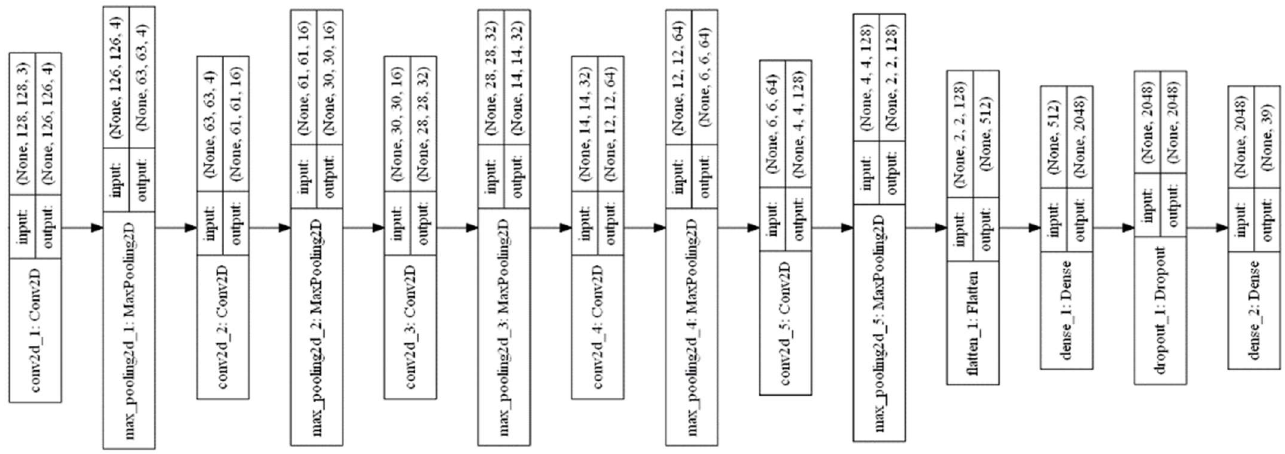
Figure 14. Layered structure of Conv-5 DCNN model.